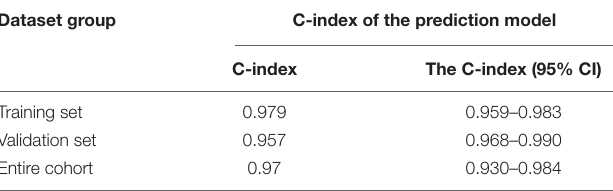
TABLE 1 | C-index of the prediction model.